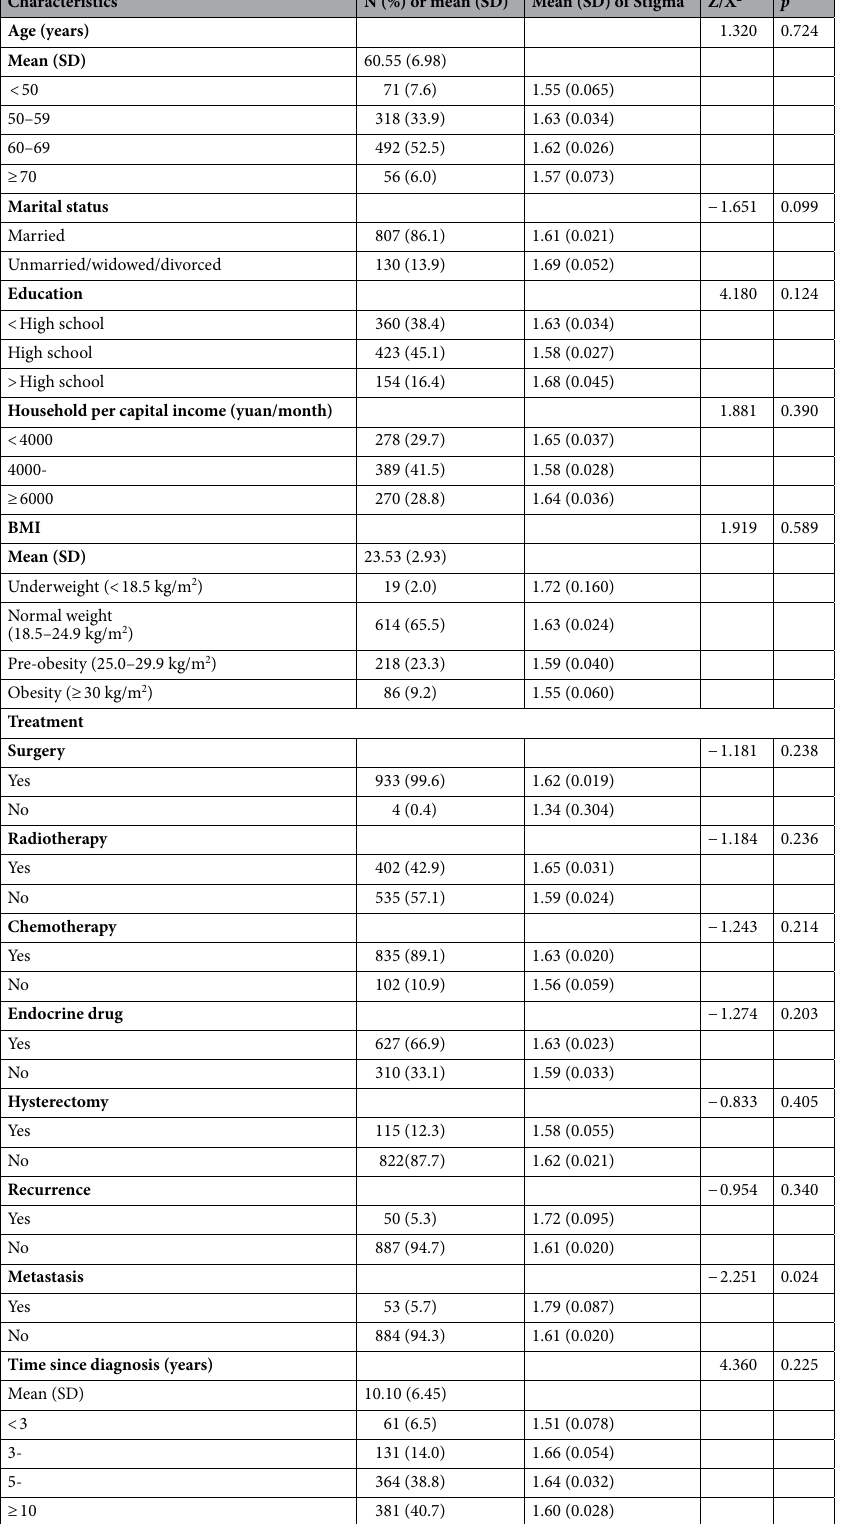
Table 1. Average score of stigma in BCSs among various basic characteristics. SD, standard